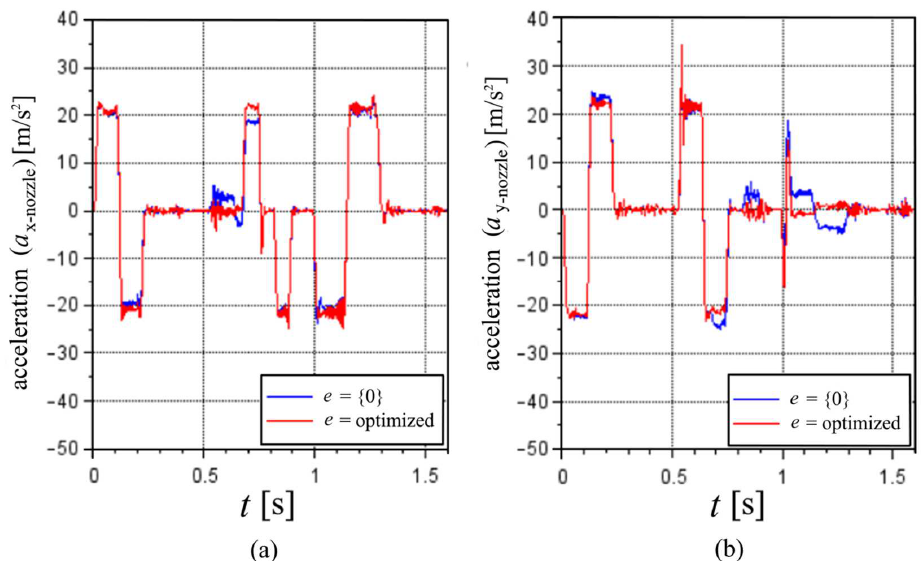
equal to zeros or op- :